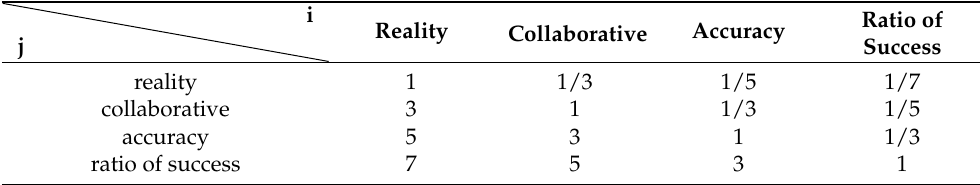
Table 4. Judgment matrix of factor layer indicators of the interactive